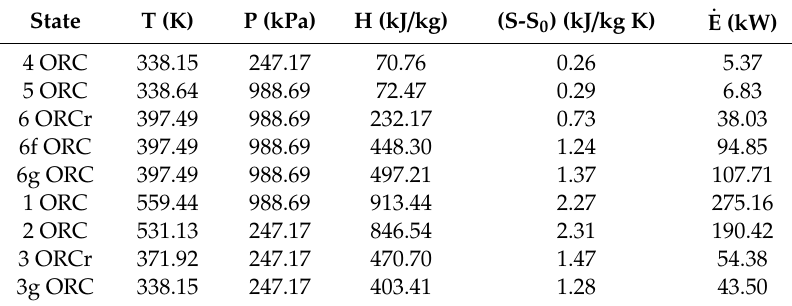
Table 6. Thermodynamic properties of the RORC system.